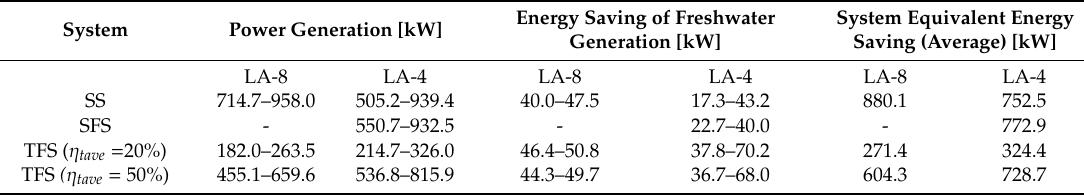
Table 3. Equivalent energy